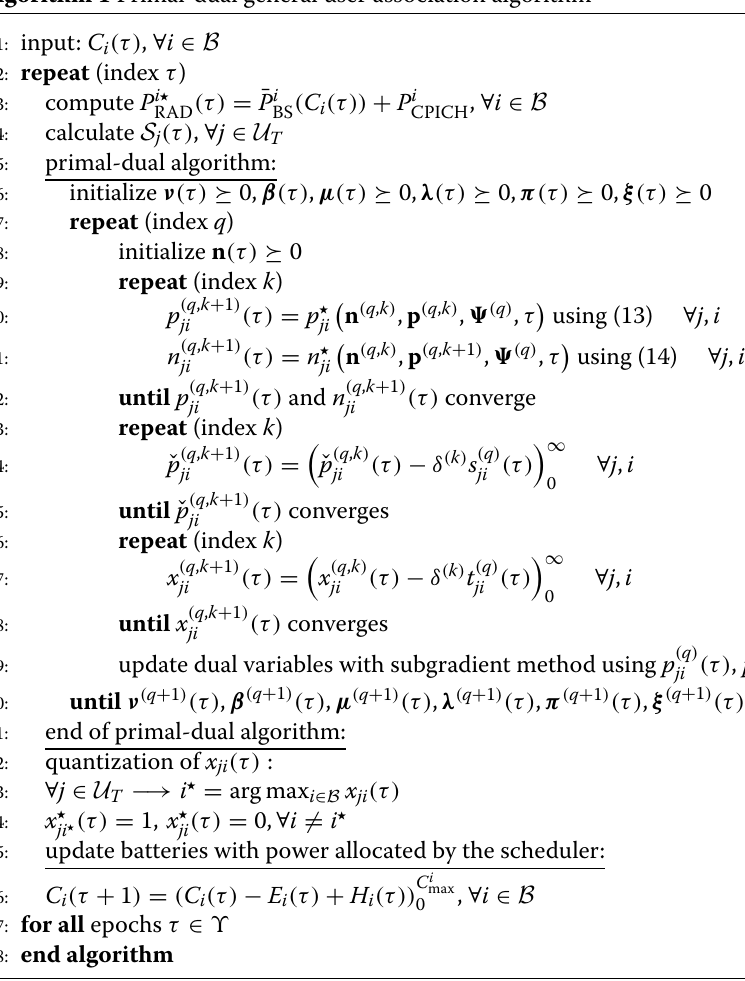
Algorithm 1 Primal-dual general user association